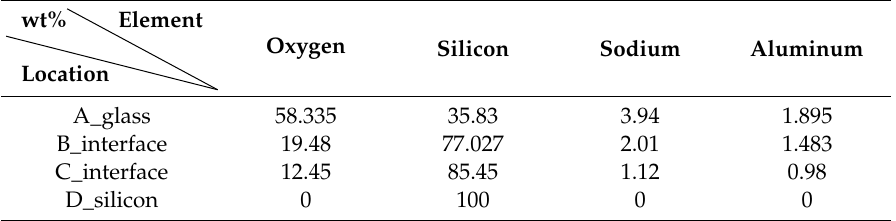
Table 1. The average weight percent (wt%) for each element in four various regions.